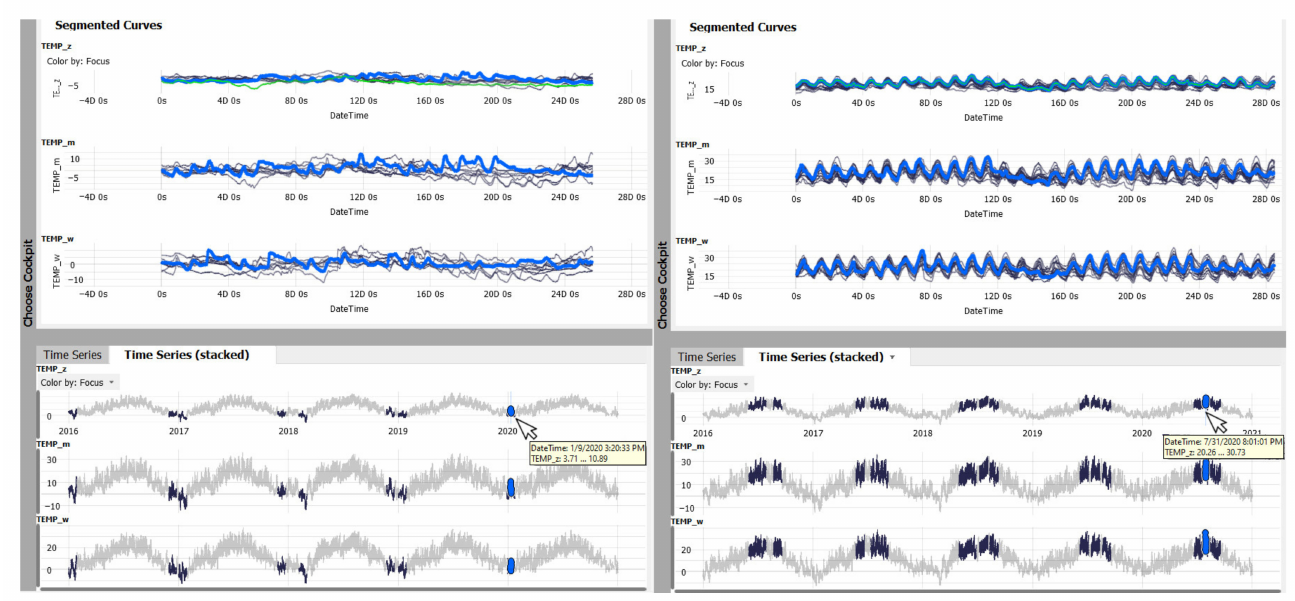
Figure 6. Composite view of comparative seasonal pattern analysis for air temperature minima and maxima carried out for the short-term dataset: winter ( left ); summer ( right ).